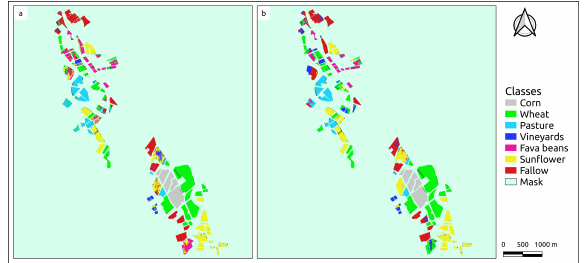
Figure 7. Classified Images in Scenario 4: a) RF (number of trees:10) for the time series number 1 with bands and indices. b) SVM (Kernel Type: ’LINEAR’. cost: 10) for the time series number 1 with